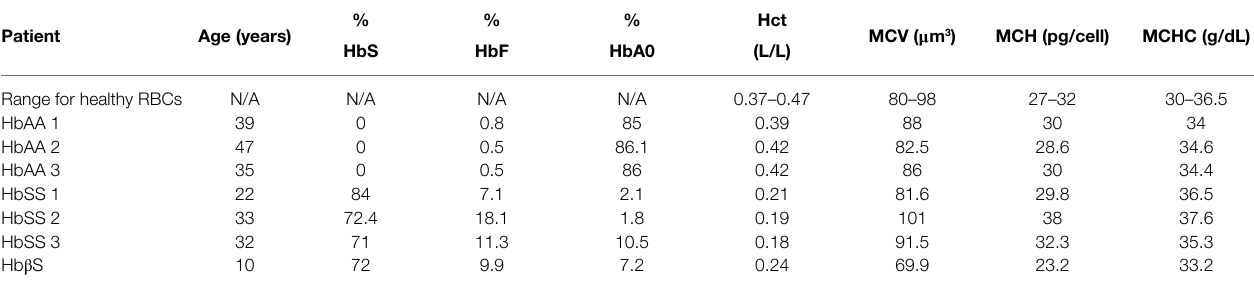
TABLE 2 | Age and hematological data of donors.